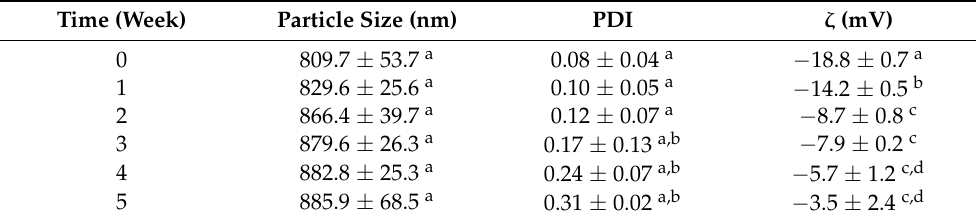
Table 2. Particle size (PS), polydispersity index (PDI), and zeta potential ( ζ ) of the SLN. Time